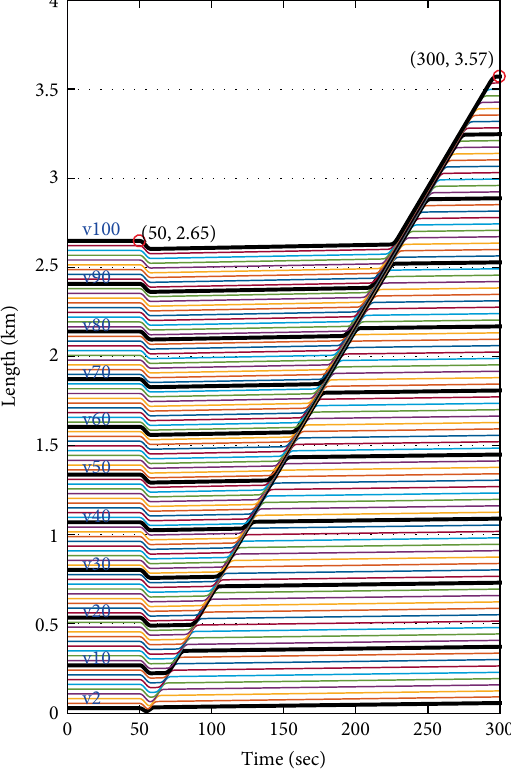
Figure 2: Space headway between 1st vehicle and 99 following vehicles.